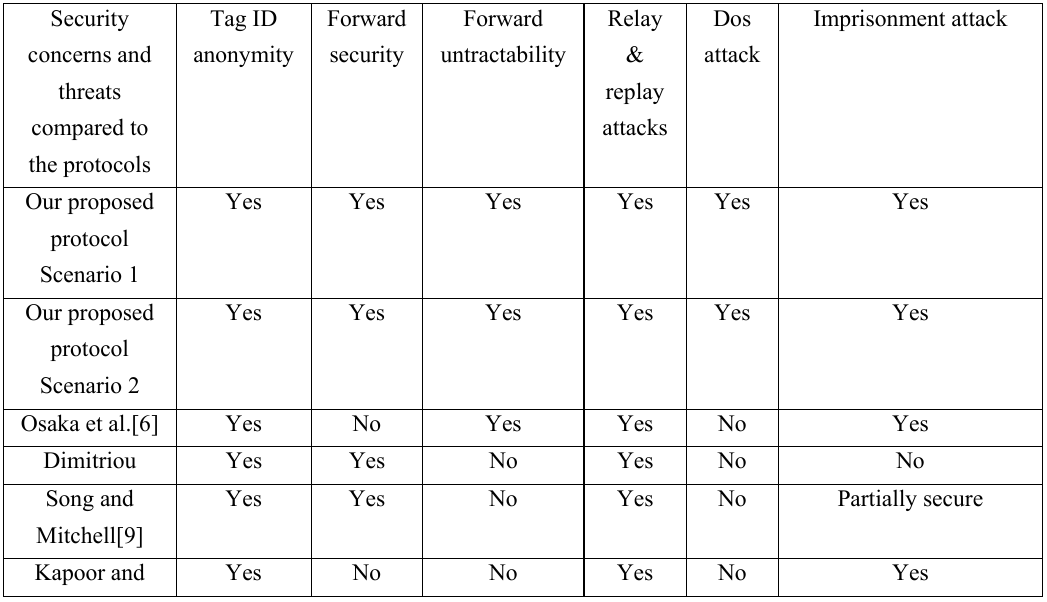
Table 2: Comparison between proposed and a number of existing